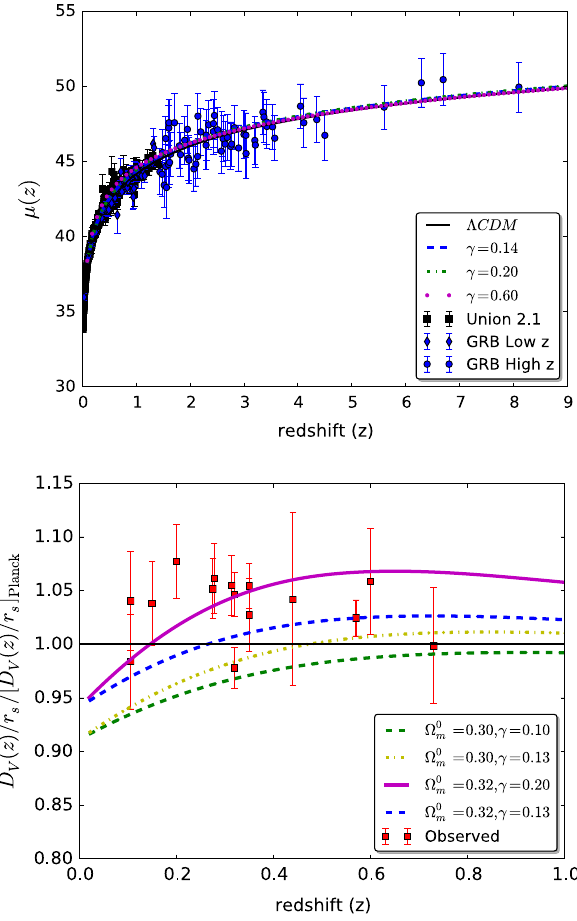
Fig. 12 Upper panel distance modulus of bulk viscous model com- pared with JLA and GRBs data. Lower panel BAO observables for the viscous dark energy and Λ CDM models. The observed data sets are reported in Table